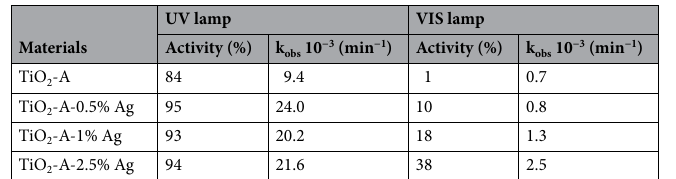
Table 9. Activity and kinetic constant of pristine and Ag NPs modified TiO 2 (UV vs. VIS lamp irradiation).